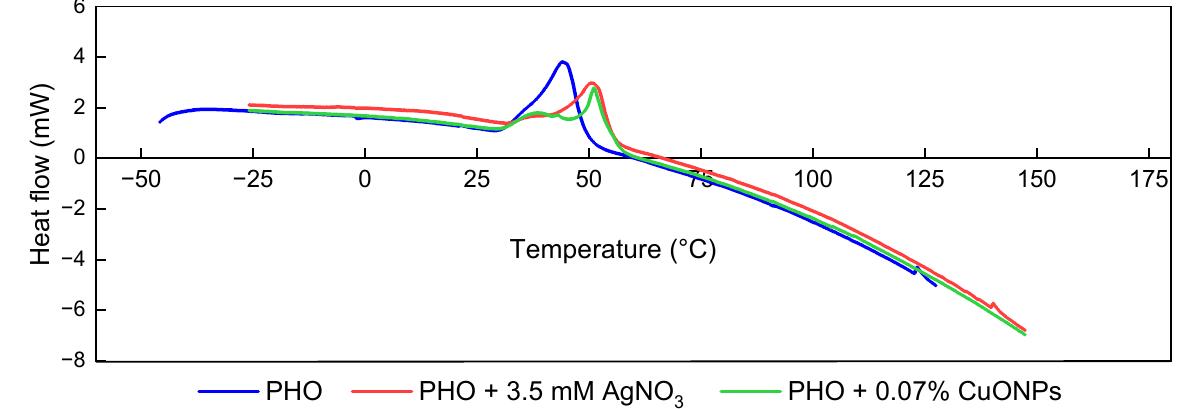
Figure 5. DSC thermograms of the first heating run of PHO films with and without NPs. Table 2. DSC maximum of melting (Tm) and melting enthalpy ( ∆ Hm) calculated from the first heating scan of PHO